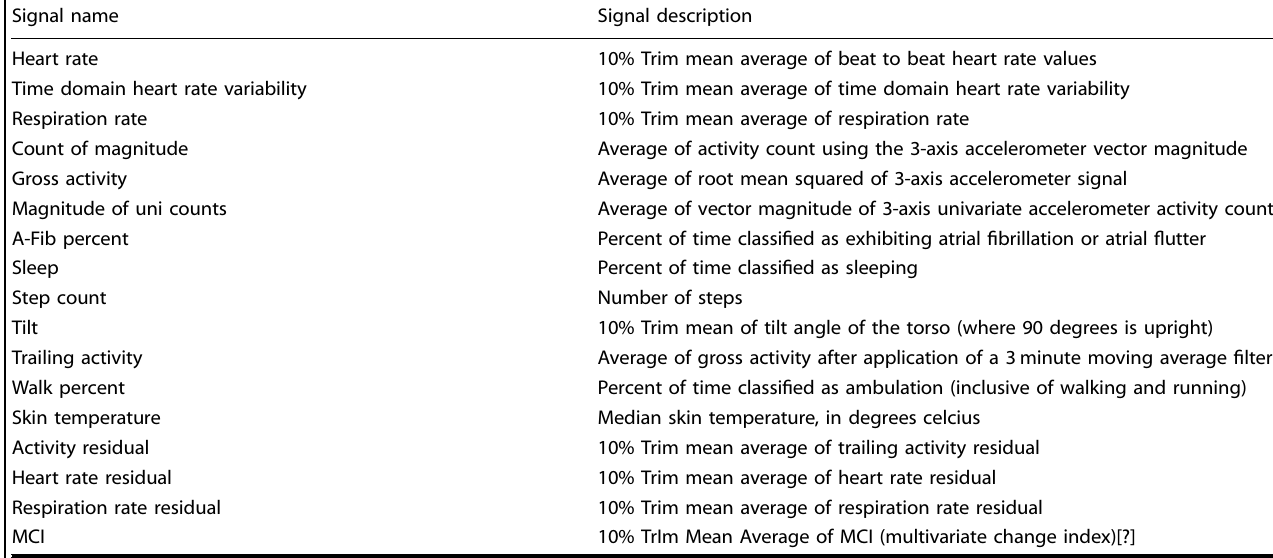
Table 3. Minute signals used as the source signals for feature extraction in the CDI